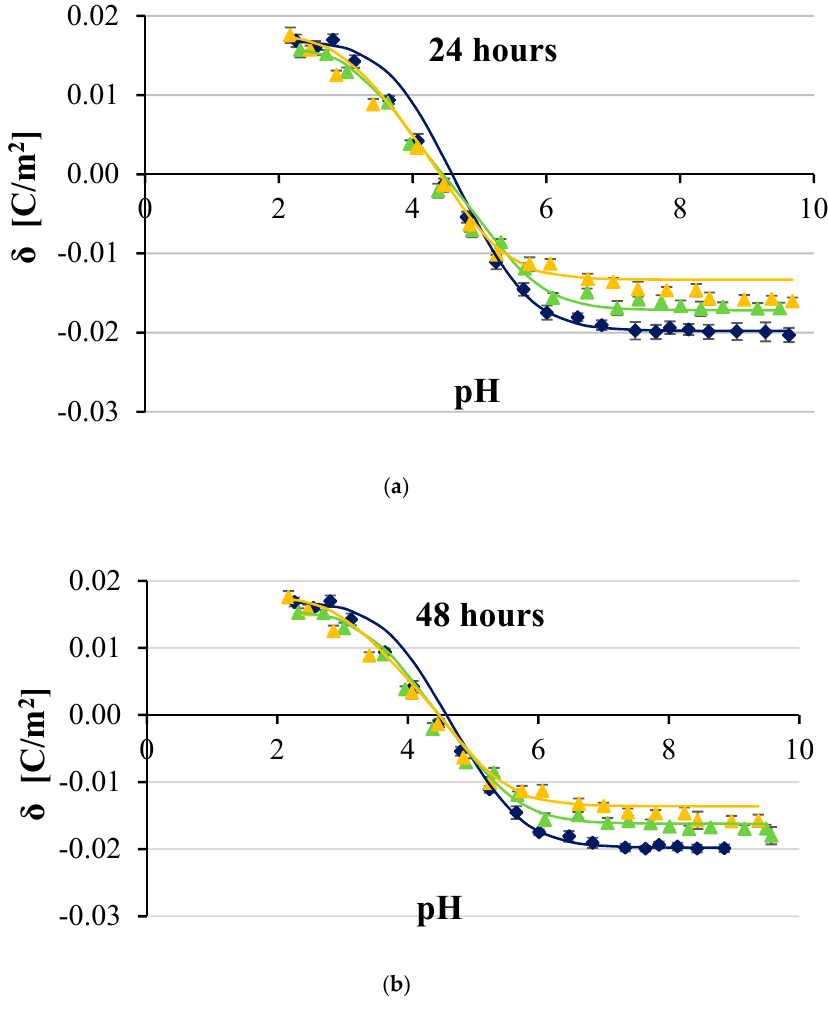
Figure 5. Dependence of surface charge density of glioblastoma T98G cell line as a function of the pH of the electrolyte solution. The cells were untreated (navy blue) or treated with 5 (green) and 8 (orange) mmol / dm 3 of p-coumaric acid for 24 h ( a ) and 48 h ( b ). Solid lines describe theoretical values; experimental data are marked by points.